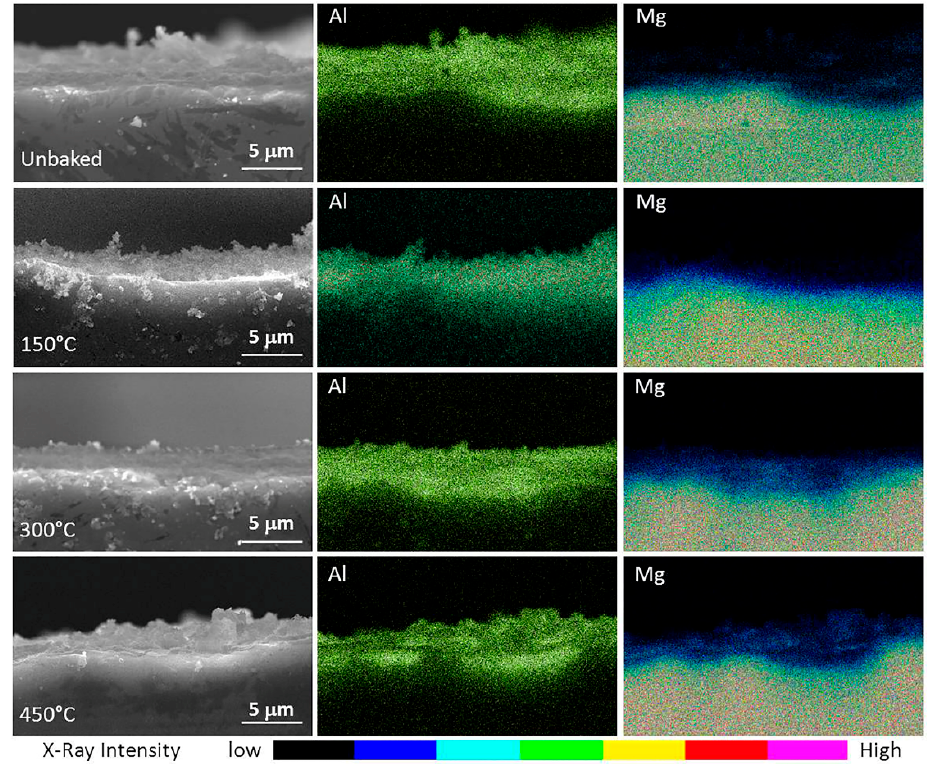
Figure 7. SEM-EDS images of the specimens highlighting the alumina and magnesium content of the coating.